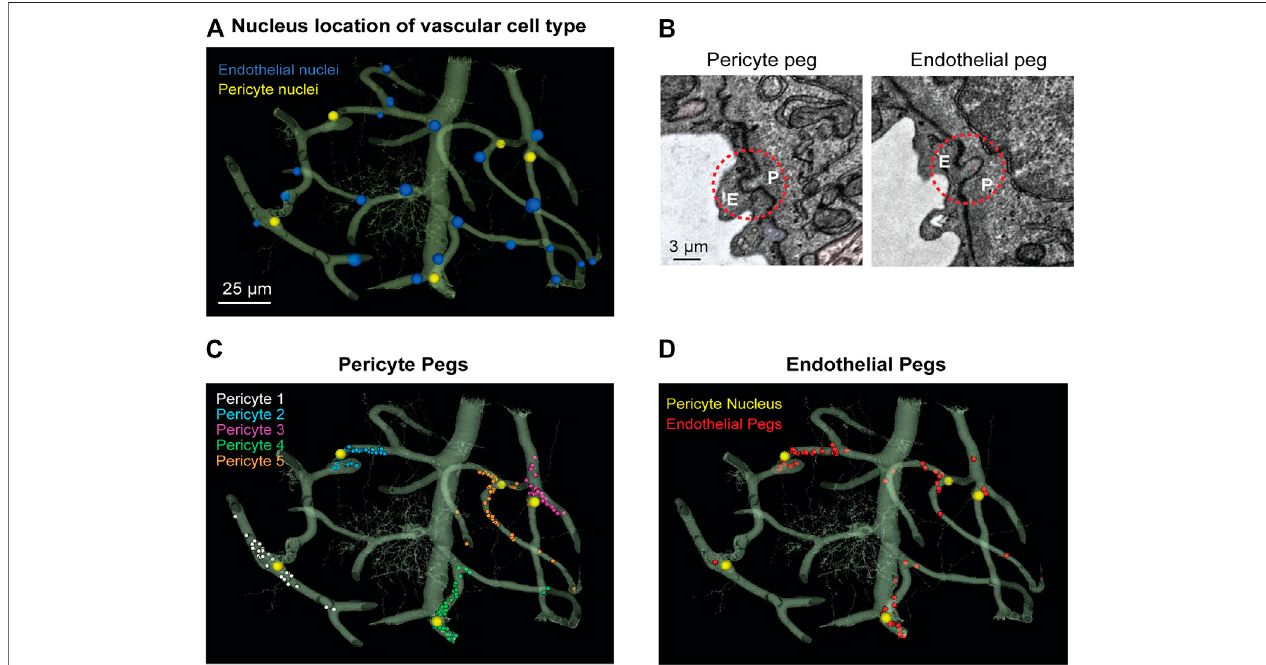
FIGURE1| MICrONSLayer2/3pericyte-endothelialinteractions. (A) Thelocationofallendothelialandpericytenucleiidenti fi edwithintheMICrONSLayer2/3data set. (B) Examples of pericyte pegs extending into the endothelium (left), and conversely, endothelial pegs extending into the pericyte (right). (C) The location of pericyte pegs mapped onto the 3D microvascular network reveals that pegs are enriched at sites of pericyte somata. The pericyte somata are labeled with yellow spheres, and the individual pegs are labeled with smaller colored spheres, color-coded per pericyte. (D) The location of endothelial pegs are also enriched around pericyte somata. Images adapted from (Ornelas et al., 2021). Link to annotations (See methods to register and agree to terms of service): https://neuromancer-seung-import. appspot.com/?json_url=https://globalv1.daf-apis.com/nglstate/api/v1/5073246747623424.